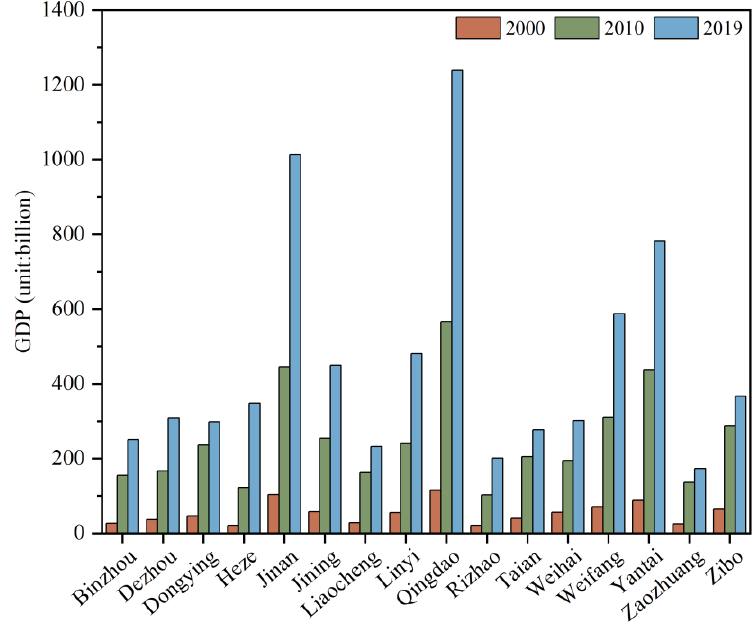
Figure 9. GDP of cities in urban agglomerations from 2000 to 2019.